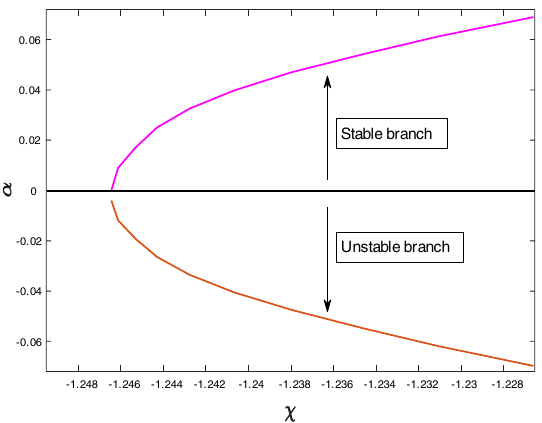
Figure 7. The smallest eigenvalues α for various values of χ